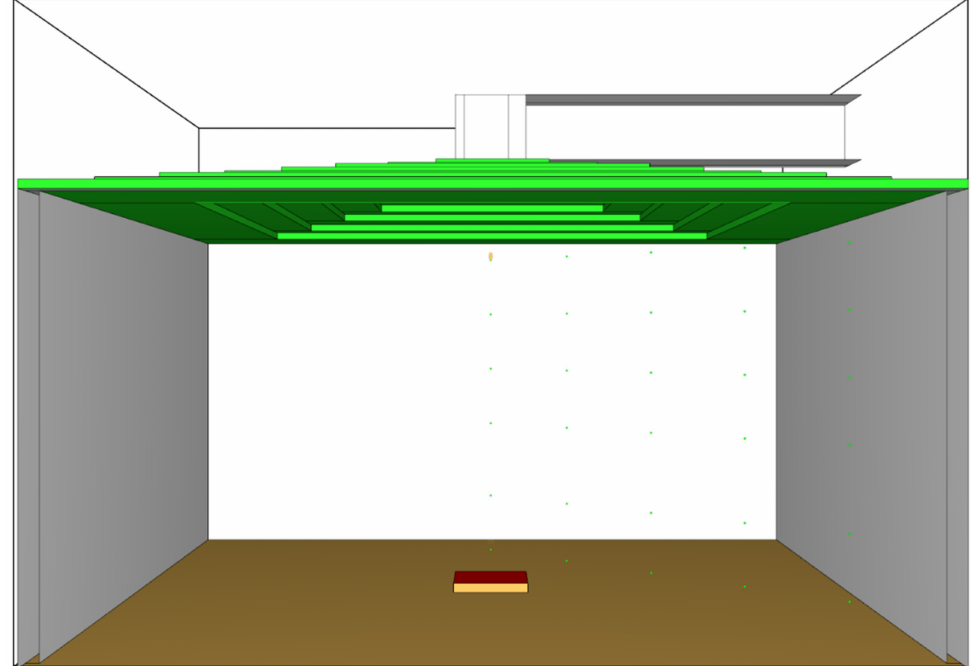
Figure 2. Snapshot of the compartment geometry in